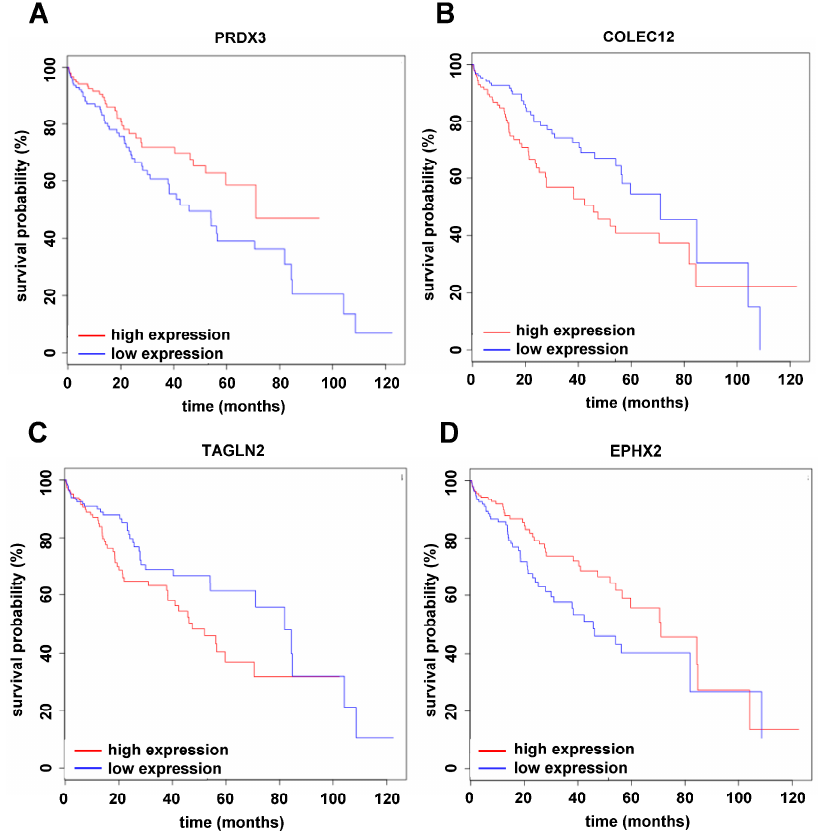
Figure 5. Survival analysis of ( A ) peroxiredoxin-3 (PRDX3); ( B ) collectin 12 (COLEC12); ( C ) transgelin-2 (TAGLN2) and ( D ) epoxide hydrolase (EPHX2) using the dataset RNASeq V2 from the TCGA. All RNA species showed significant differences between experimental groups; * p < 0.05.